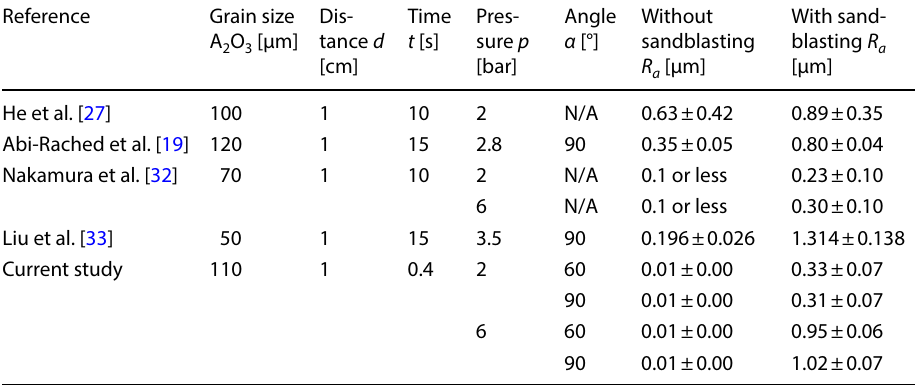
Table 2 Parameters and before mean roughness R a and after sandblasting from a selection of other studies and the present paper (selected parameter combinations for